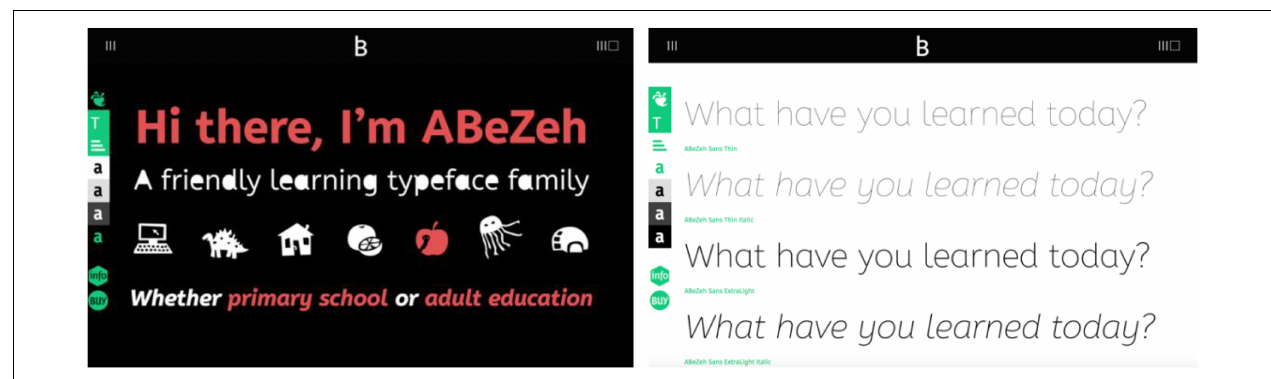
FIGURE 3 | Animation viewing.